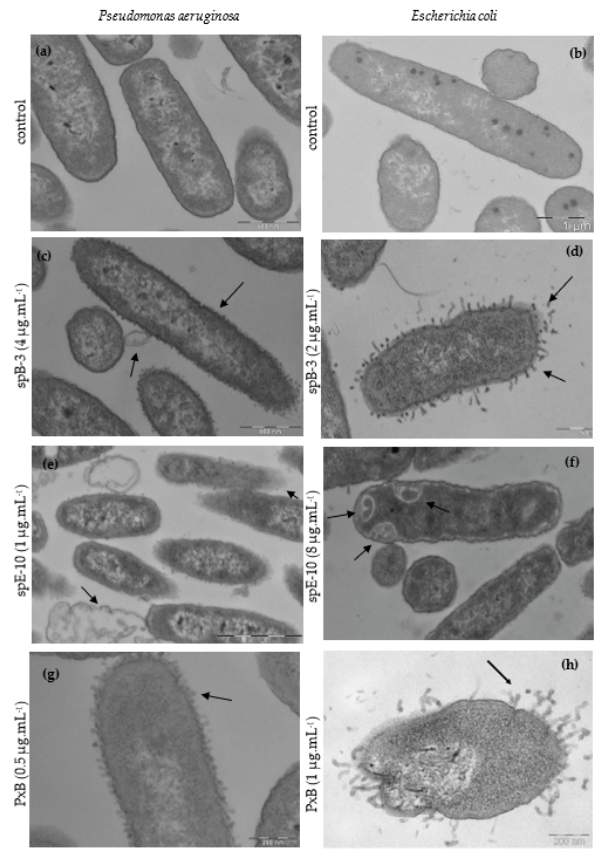
Figure 3. Comparative TEM micrographs of P. aeruginosa (left) and E. coli (right). Untreated bacteria ( a , b ); bacteria treated with polymyxin analogues at 1xMIC: P. aeruginosa with spB-3 (4 µg.mL − 1 ) ( c ), or with of spE-10 (1 µg.mL − 1 ) ( e ); E. coli treated with spB-3 (2 µg.mL − 1 ) ( d ) or spE-10 (8 µg.mL − 1 ) ( f ). Lipopeptides cause the alteration of the membranes, with blebs protruding, loss of membrane, clear cytoplasmic zones, and even ghost cells. Similar results are obtained with natural PxB (( g , h ), this last one is adapted from from [26] (Rabanal et al. Sci. Rep. 2015). Since some of the polymyxin analogues also have good activities against S. aureus